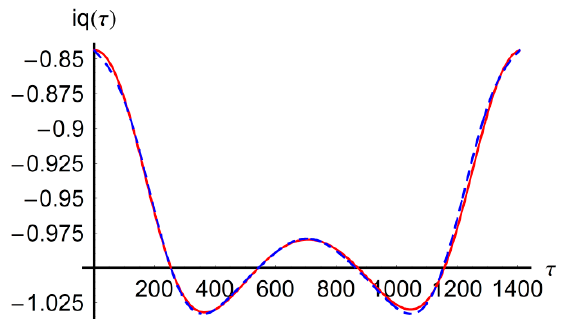
Figure 1. Comparison between the approximate solution and numerical integration results for i d :